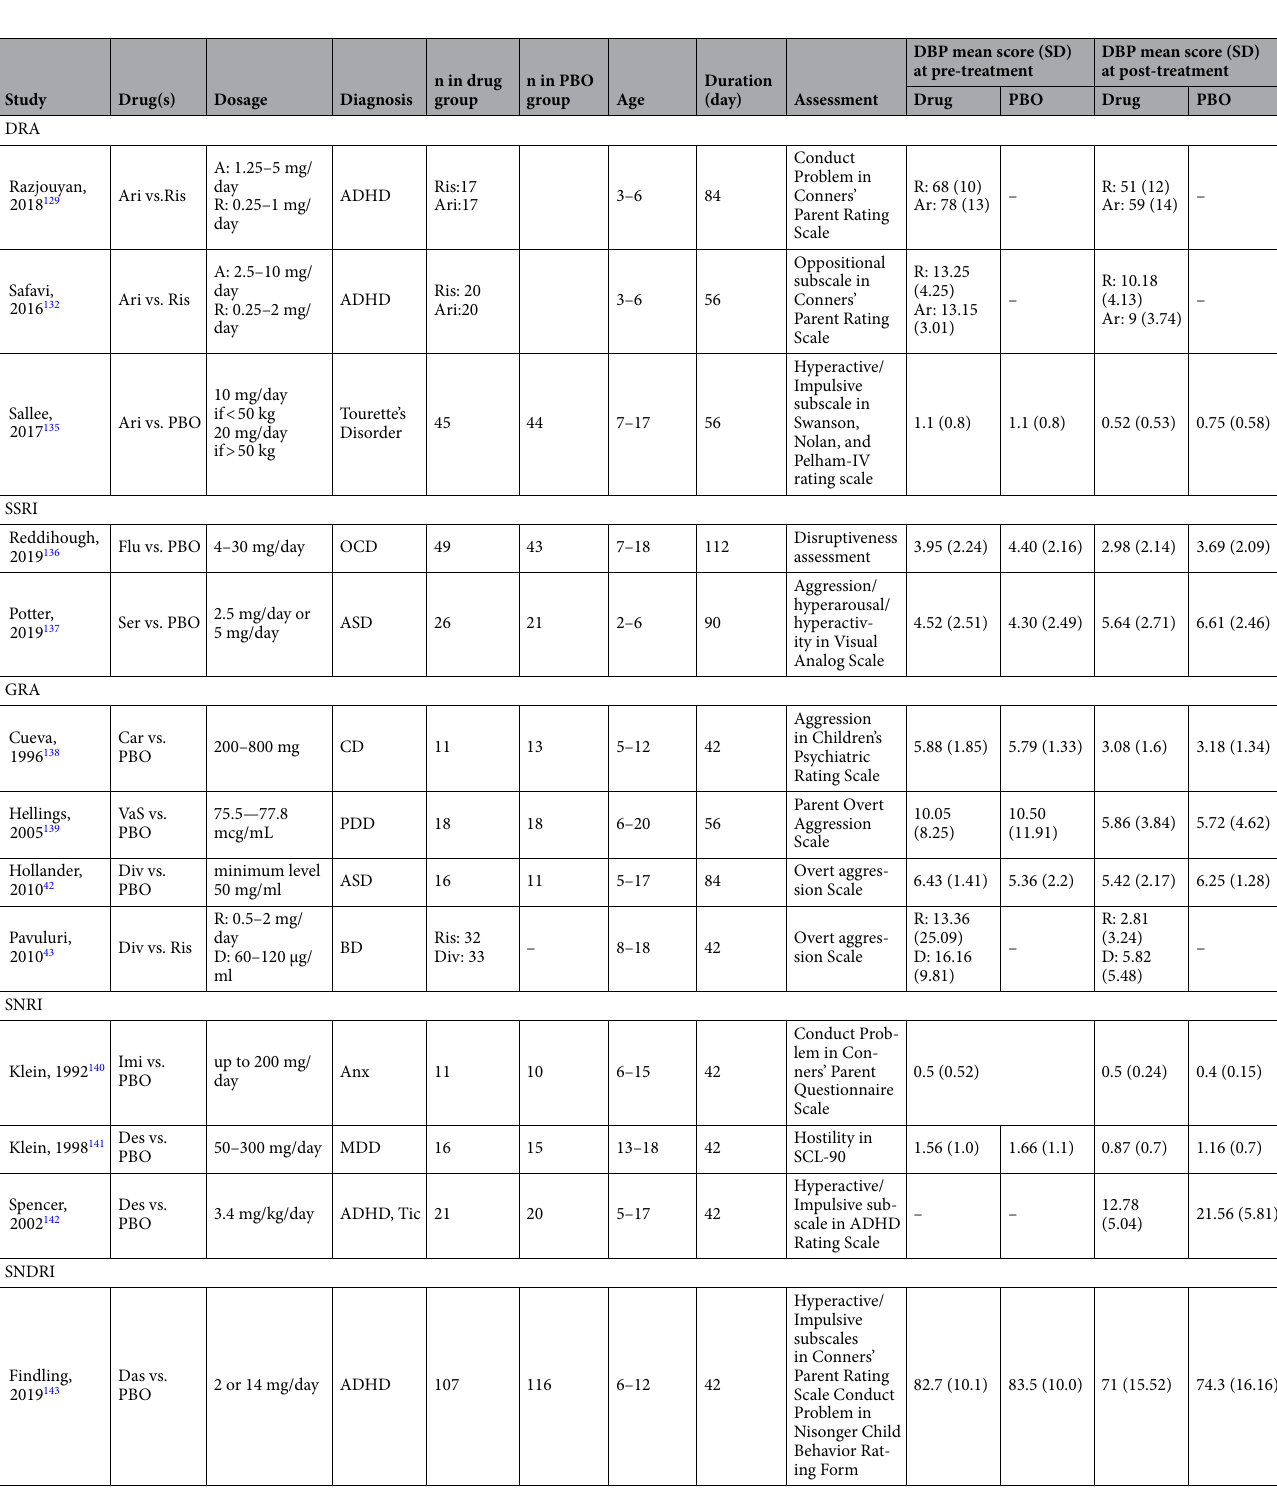
Table 2. Studies measuring the symptoms of disruptive behavior problem. ADHD Attention deficit hyperactivity disorder, Anx Anxiety disorder, Ari Aripiprazole, ASD Autism spectrum disorders, Ato Atomoxetine, BD Bipolar disorder, Car Carbamazepine, CD Conduct disorder, DBD Disruptive behavior disorders, Das Dasotraline, Des Desipramine, Div Divalproex, Flu Fluoxetine, Imi Imipramine, IR Immediate- release, Li Lithium, MDD Major depressive disorder, MPH Methylphenidate, OCD Obsessive–compulsive disorder, ODD Oppositional defiant disorder, Ola Olanzapine, OROS Oral dosage form, PBO Placebo, PDD Pervasive developmental disorder, Que Quetiapine, Ris Risperidone, Ser Sertraline, VaS Valproate